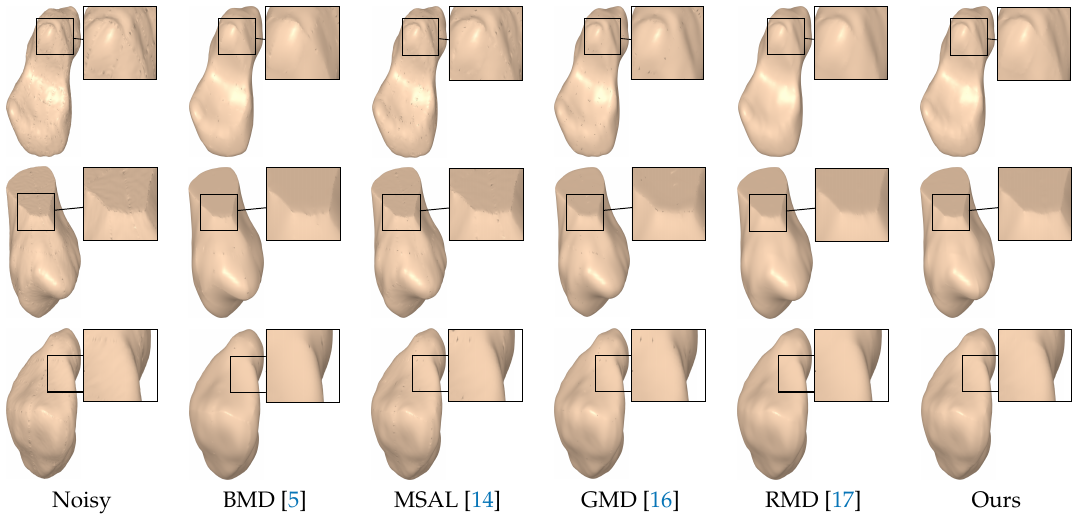
Figure 7. Surface denoising results for the noisy scaphoid, left metacarpal, and left hamate models. The noise standard deviation was set to σ =